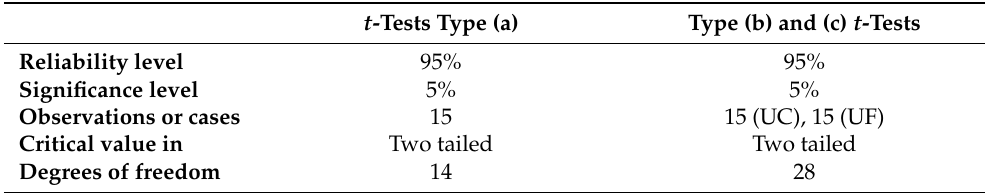
Table 4. Values used for t -tests.